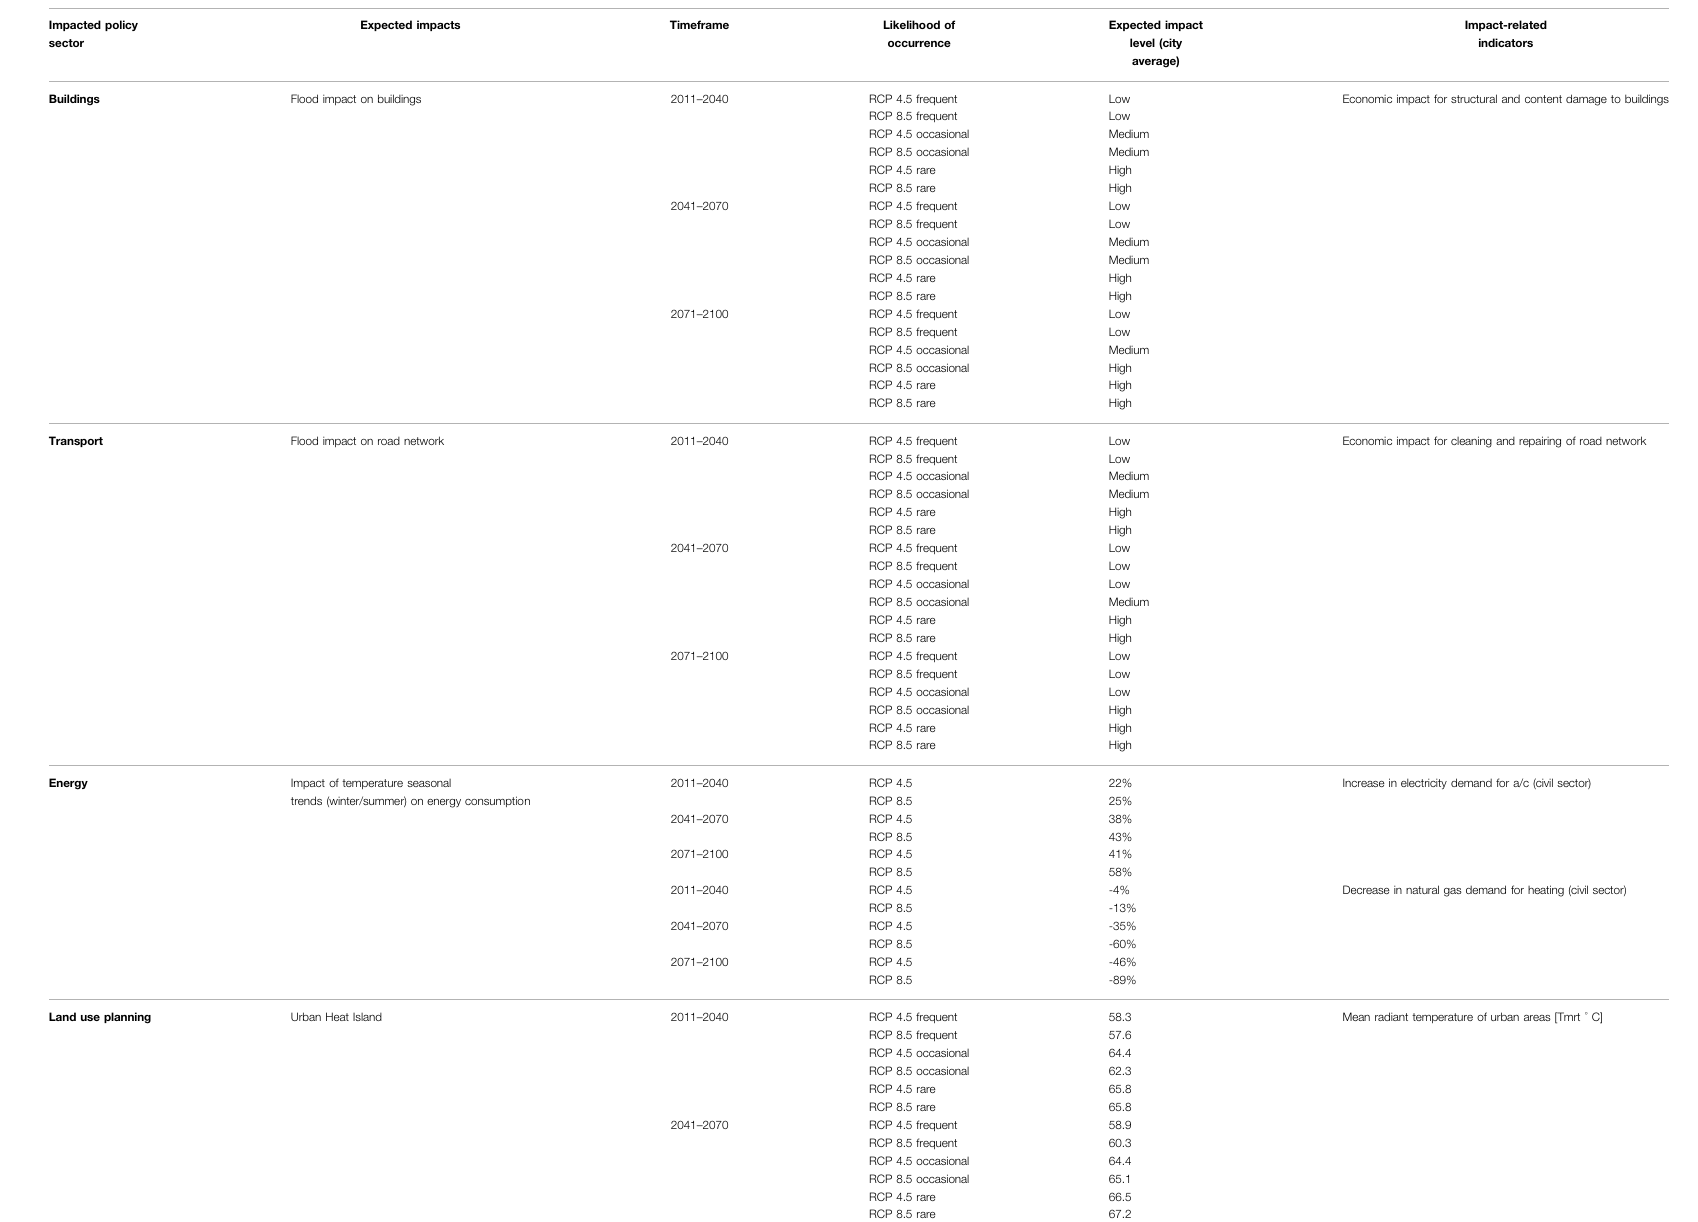
TABLE 1 | Summary of impact indicators calculated for the Naples